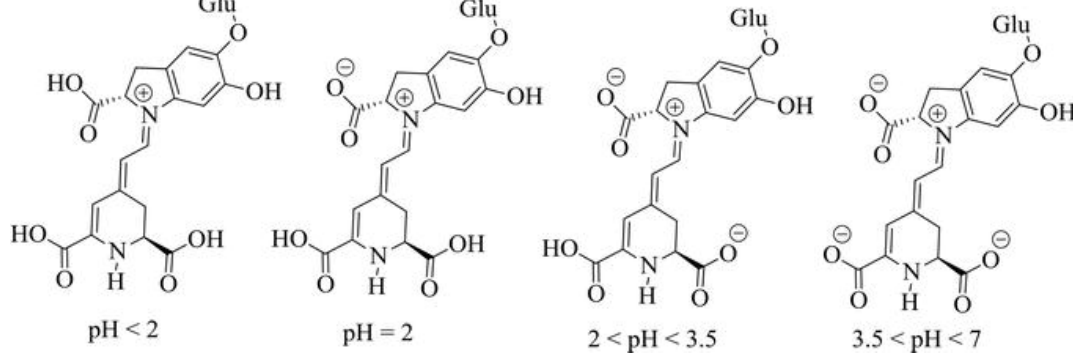
Figure 13. Structures of betanin as the pH varies